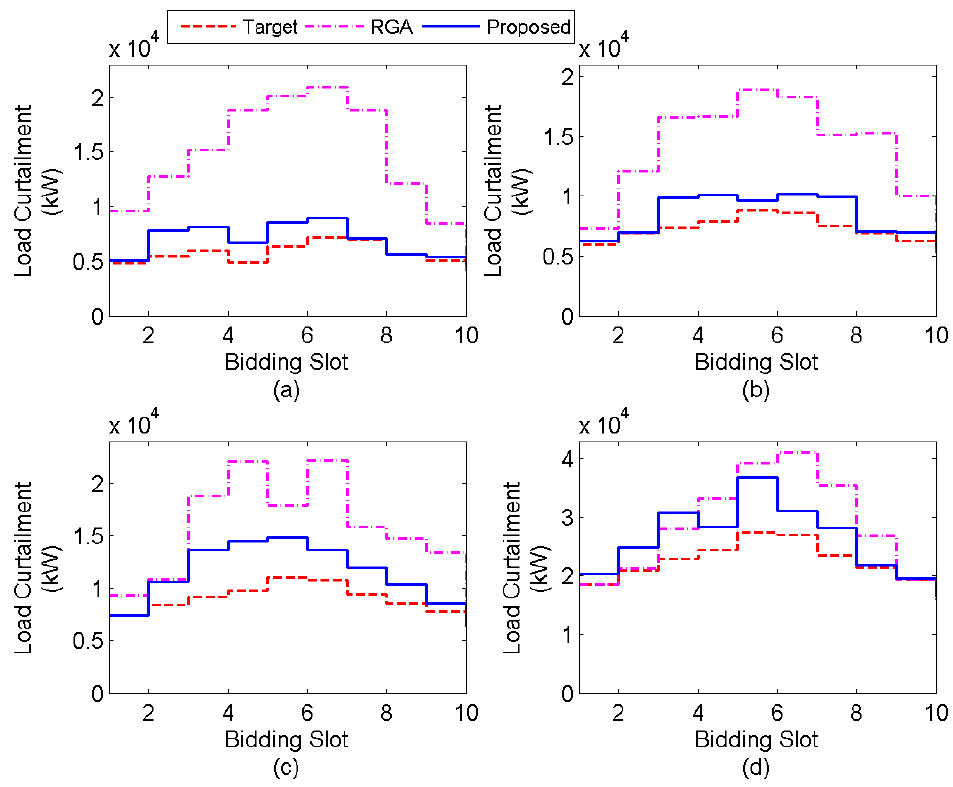
Figure 7. The actual load curtailment profiles produced by both compared methods with respect to the target profile under the use rates of ( a ) 1.3 α , ( b ) 1.6 α , ( c ) 2.0 α , and ( d ) 5.0 α .